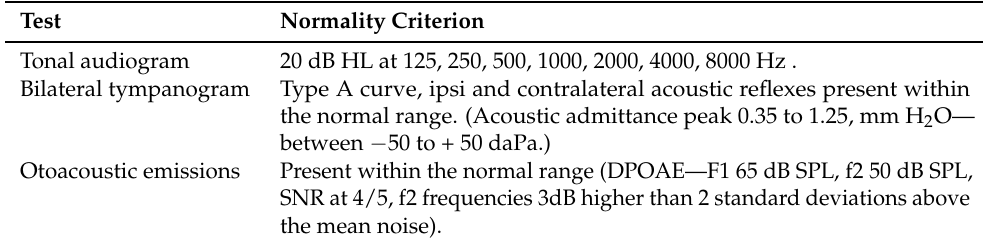
Table 2. The criteria adopted for normal hearing.